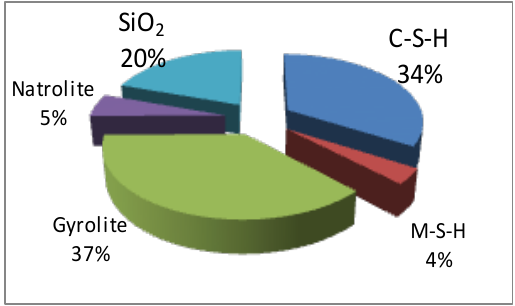
Figure 25. Weight % of solids predicted by thermodynamic simulation at 20 °C.